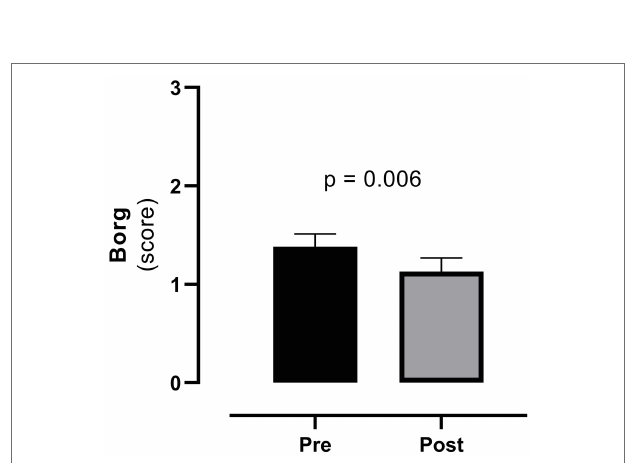
FIGURE 2 | Cumulative value of the Borg scale before (pre) and after (post) cardiac rehabilitation. Legend: the boxes refer to mean and bars refer to